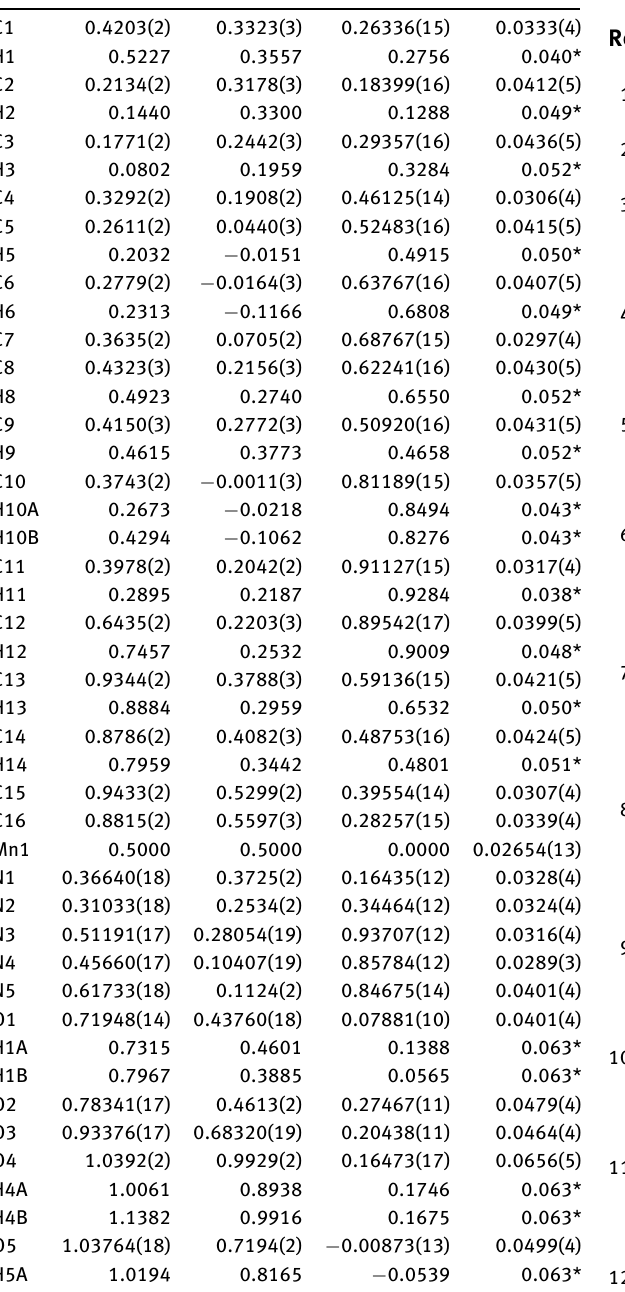
Table 2: Fractional atomic coordinates and isotropic or equivalent isotropic displacement parameters (Å 2 ).